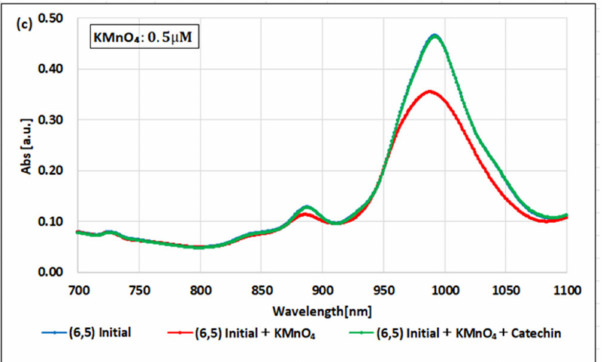
Figure 2. NIR-absorbance spectra of the dsDNA-(6,5)-enriched SWNT complex during redox with ( a ) H 2 O 2 and catechin, ( b ) K 2 IrCl 6 and catechin, and ( c ) KMnO 4 and catechin. The data are presented as the average of three independent